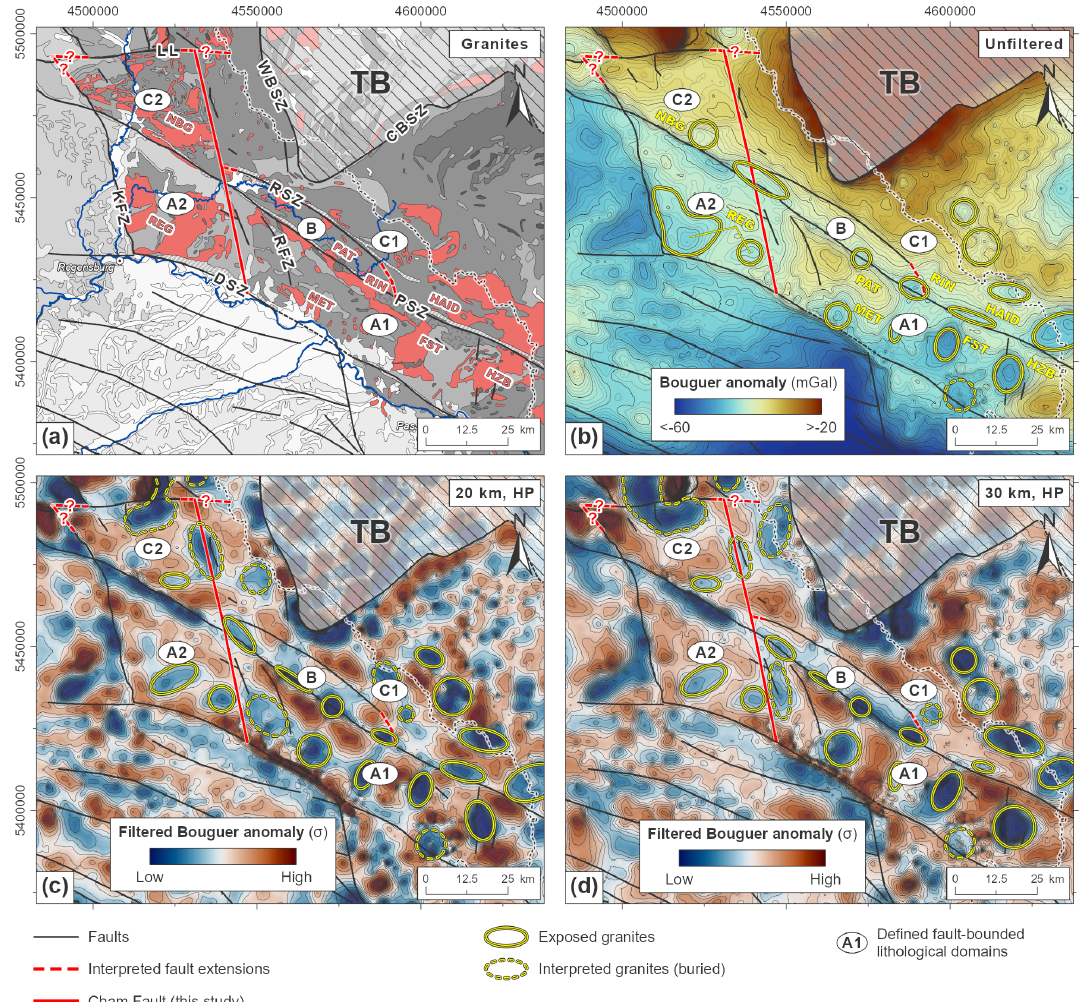
Figure 4. Compilation of unfiltered and filtered gravity data. (a) Gray-scaled geological map of the southwestern Bohemian Massif with exposed late Variscan granites highlighted in red (modified from Freudenberger and Schwerd, 1996; Toloczyki et al., 2006; Teipel et al., 2008; Galadí-Enríquez et al., 2009b). (b) Unfiltered Bouguer anomaly map of the study area and its surroundings (data source: Leibniz- Institut für Angewandte Geophysik, 2010; Skiba, 2011). (c) – (d) High-pass-filtered gravity data (20 and 30km wavelength, respectively) depicting the upper-crustal configuration of the study area. The data are color-coded with respect to their standard deviation ( σ ) to highlight relative gravity highs and lows. Traces of major fault zones and the interpreted Cham Fault, as well as the locations of exposed and interpreted granite bodies, are shown. The scientific color maps “roma” (b) and “vik” (c, d) (Crameri, 2021) are used to prevent visual distortion of the data and exclusion of readers with color-vision deficiencies (Crameri et al., 2020). Fault zones: CBSZ – Central Bohemia Shear Zone; DSZ – Danube Shear Zone; KFZ – Keilberg Fault Zone; LL – Luhe Line; PSZ – Pfahl Shear Zone; RSZ – Runding Shear Zone; RFZ – Rattenberg Fault Zone; WBSZ – West Bohemia Shear Zone. Exposed granite bodies: FST – Fürstenstein Composite Massif; HAID – Haidel Massif; HZB – Hauzenberg Composite Massif; MET – Metten Massif; NBG – Neunburg Massif; PAT – Patersdorf Stock; REG – Regensburg Forest Massif; RIN – Rinchnach Stock; names after Klomínský et al. (2010). TB –